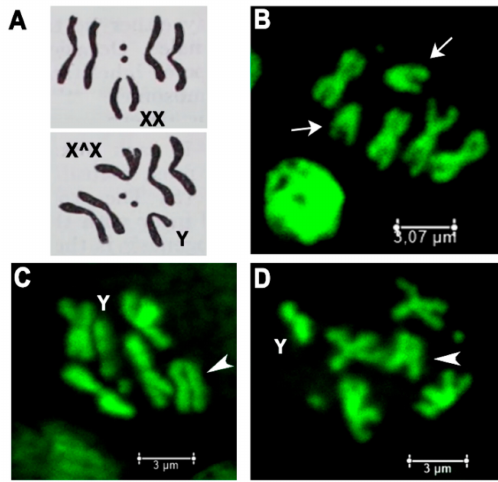
Figure 2. Females with Trf2 lethal mutations have attached-X chromosomes. ( A ) Schemes of wild type female metaphase plate carrying normal X (upper panel) and attached-X and Y (lower